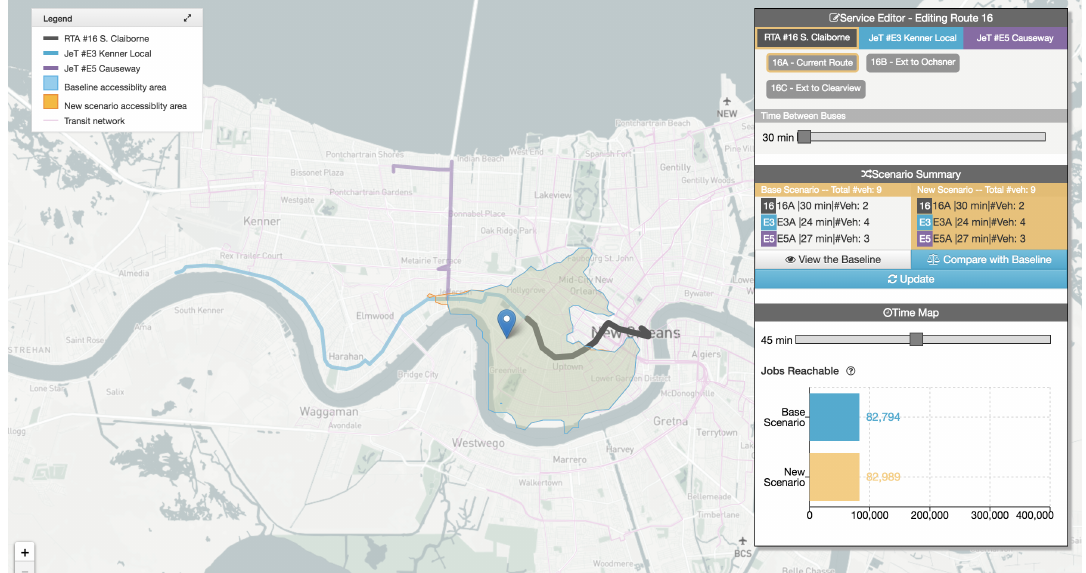
Figure 21. The CoAXs visualization tool for accessibility-based stakeholder engagement [81] (extracted from